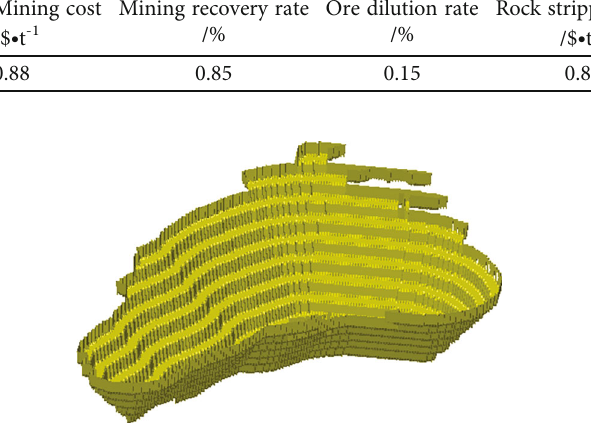
Figure 13: Program III mining pit fi nal realm